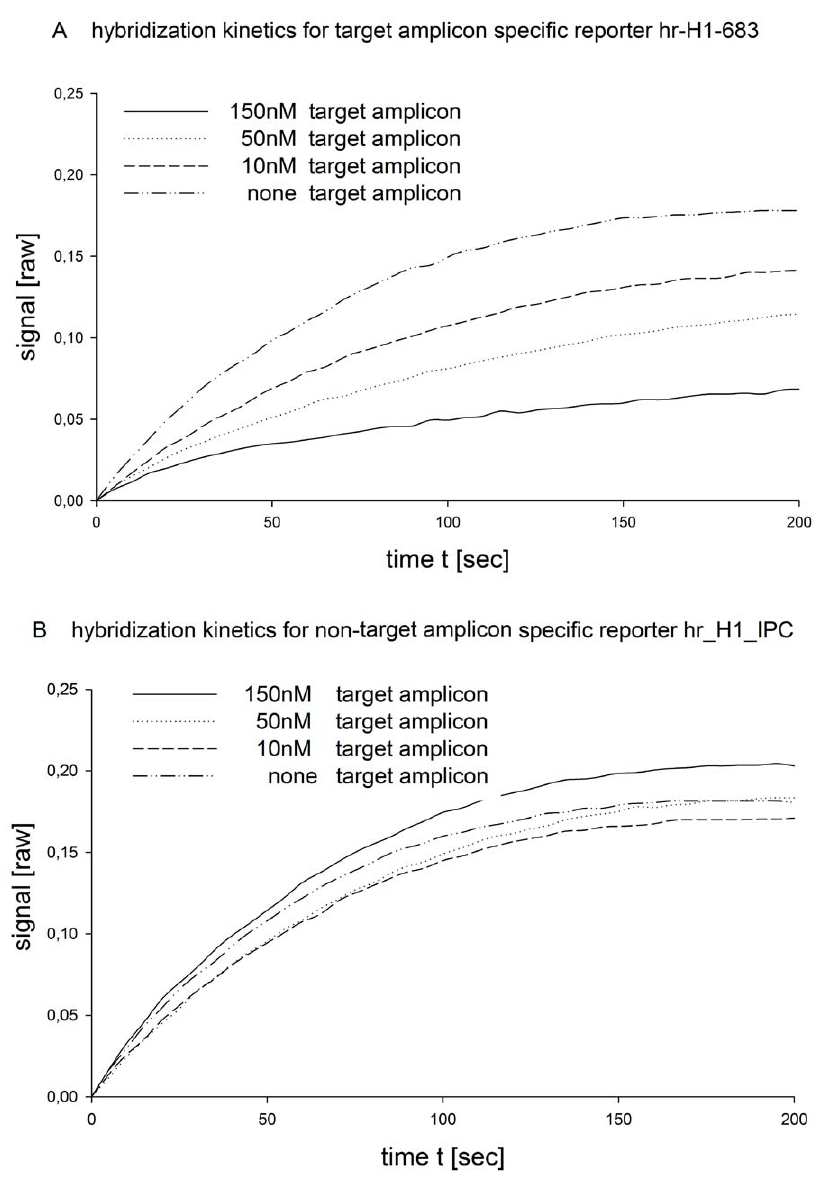
Figure 1. Differences in the hybridization kinetics of a target specific reporter probe and a non-target specific reporter probe. A. The diagram shows the kinetics of reporter probe hr-H1-683 in presence of different amounts of hr-H1-683 specific target amplicon. As indicated in the diagram, hybridization speed strongly depends upon the amount of target amplicon present in the reaction. With no target amplicon present in the reaction, reporter probes are available to bind to their complementary capture probes on the array. With increasing amounts of target amplicon, the speed of reporter probe binding to the respective capture probe decreases. Finally, in the presence of approximately the target amplicon concentration expected for a completed PCR- Reaction (150 nM), the reaction speed is at its lowest point. B. The data illustrate that the effect is sequence specific. The speed of hybridization of non-target specific reporter probes to their respective capture probes does not depend on the concentration of target amplicons in